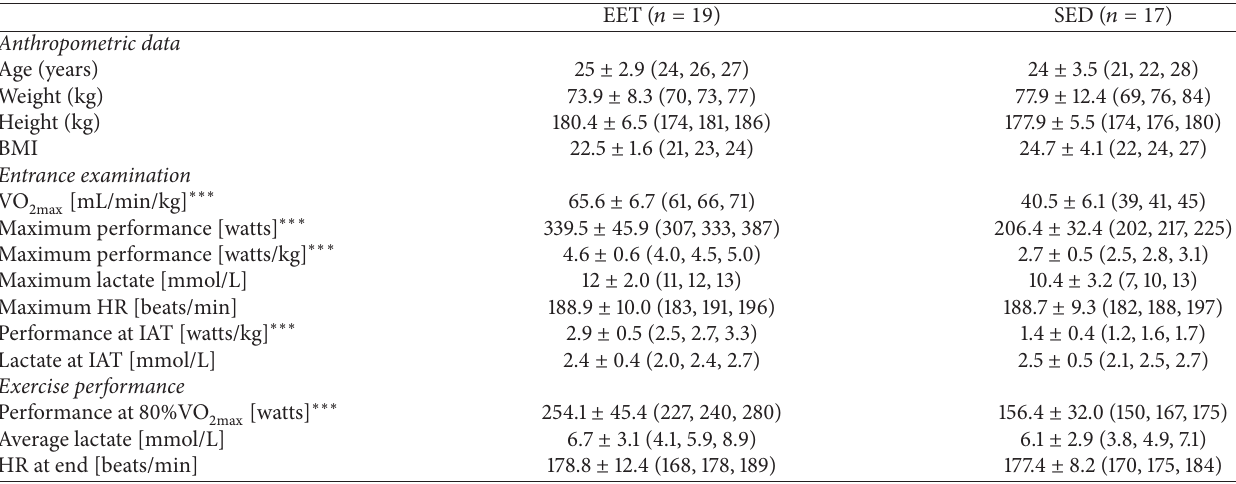
Table 1: The anthropometric data and performance results of the entrance examination and endurance exercise of EET and SED individuals. Shown are mean ± SD and in parentheses the 1. quartile, median, and the 3. quartile. ∗∗∗ 𝑝 < 0.001 indicates significant differences between endurance-exercise-trained (EET) athletes and untrained/sedentary (SED)